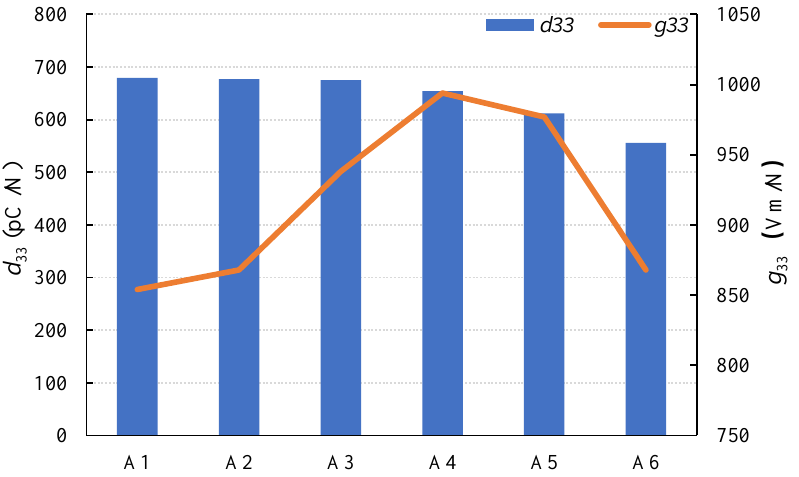
Figure 6. Changes in piezoelectric properties of specimens with SL/FA.